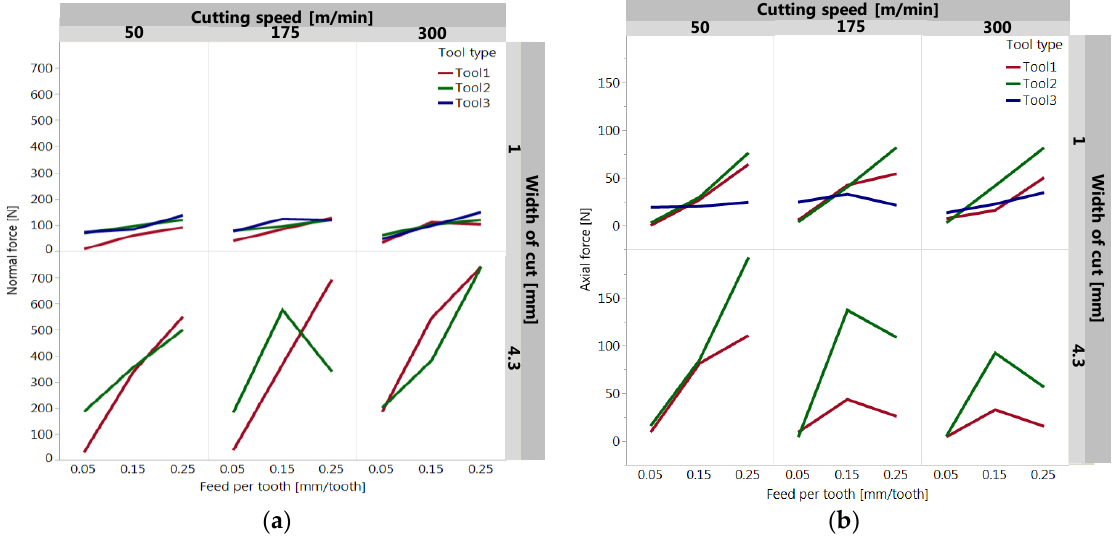
Figure 19. Cutting forces according to the different parameters: ft , v and ae tool1, tool2 and tool3: ( a ) normal force; ( b ) axial force.